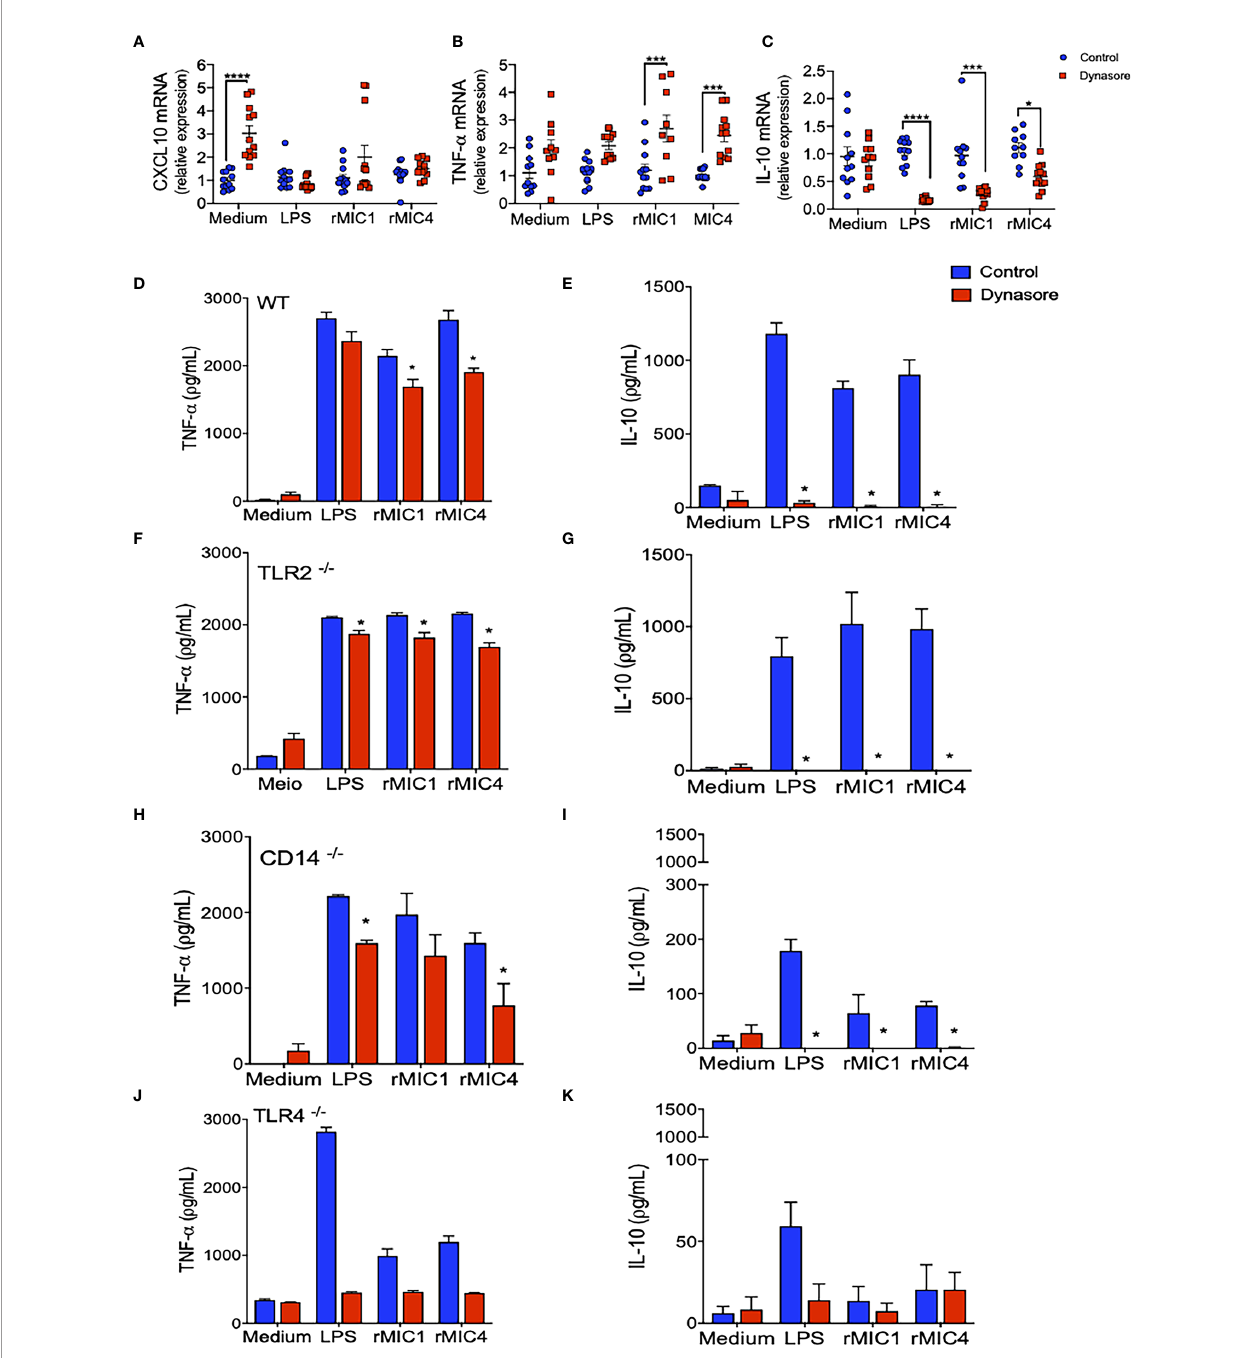
FIGURE 2 | IL-10 production by MIC1- or MIC4-stimulated BMDMs requires TLR4 and a functional endocytic pathway. (A – C) WT BMDMs pretreated (red squares) or not (control - blue circles) with Dynasore were stimulated with Medium only, LPS, MIC1, or MIC4 for 5 h. Extracted RNA was reverse transcribed into cDNA, and expression of Cxcl10 (A) , Tnf- a (B) , and Il-10 (C) was analyzed by real-time PCR. Relative expression was determined as described in “ Materials and Methods, ” and results obtained under Dynasore treatment were compared with control conditions under the same stimulation. Results are expressed as averages + SD of four experiments, each performed in triplicate. Statistical analysis was done by two-way ANOVA followed by Tukey ’ s test (* = p < 0.05, *** = p < 0.001, **** = p < 0.0001). BMDMs from WT (D, E) , TLR2 -/- (F, G) , CD14 -/- (H , I) , and TLR4 -/- (J, K) mice were pretreated (red bars) or not (control - blue bars) with Dynasore and then stimulated with medium only, LPS, MIC1, or MIC4. After 24 h, cell supernatants were analyzed by ELISA for TNF- a (D, F, H, J) and IL-10 (E, G, I, K) levels. Results are expressed as averages + SD of three independent experiments, each performed in triplicate. Statistical analysis was done by two-way ANOVA followed by Tukey ’ s test (* = p < 0.05 in comparison with control under same